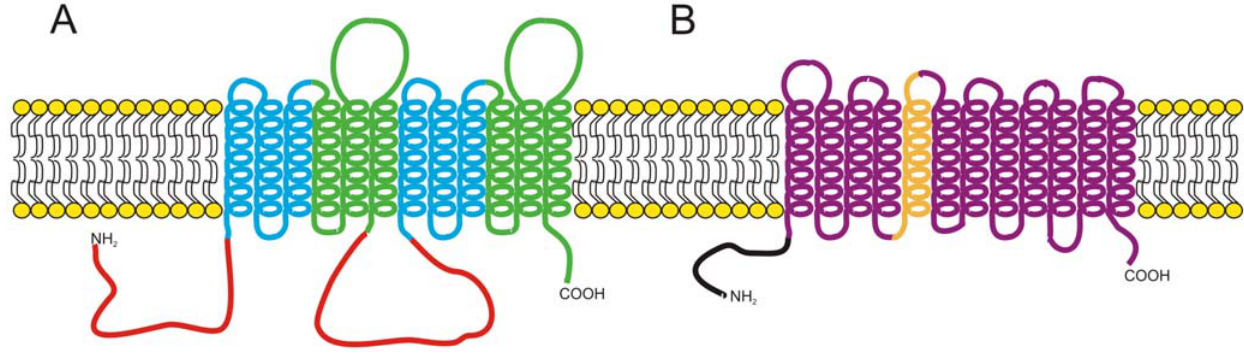
Figure 1. Schematic representation of the two main fungal transporters responsible for efflux of toxic compounds. Representation of an ABC transporter of the PDR family (A) and an MFS transporter of the DHA12 family (B). The NBDs of the ABC transporter are depicted in red, while the TMDs important for substrate specificity are colored green and gold for the ABC and MFS transporters, respectively.